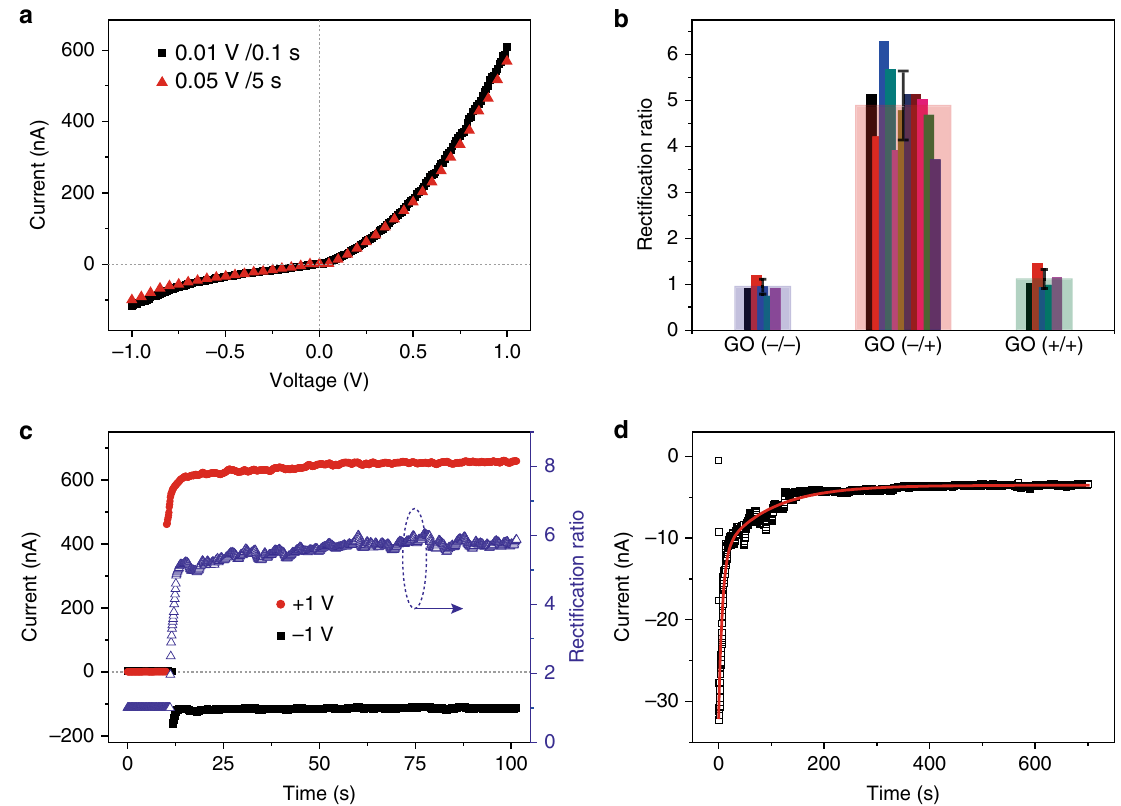
Fig. 2 Characteization of the graphene pn diode. a The typical current – voltage characteristics of a graphene pn diode with fast (black square, 0.1 V/0.1 s) and slow sweep rate (red triangle, 0.05 V/5 s). b The statistics of recti fi cation ratio of graphene pn diodes ( r , approximately 5) and two control experiments composed of either GO( − / − ) or GO( + / + ) layers, showing no current recti fi cation characteristics ( r , approximately 1). The error bar for pn diode is based on 11 devices. The error bars for control experiments are based on fi ve devices. c The current transients were monitored by stepping the potential from 0 to + 1 V or − 1 V. d The current transients was recorded upon laminating the positively charged and negatively charged GO layers.